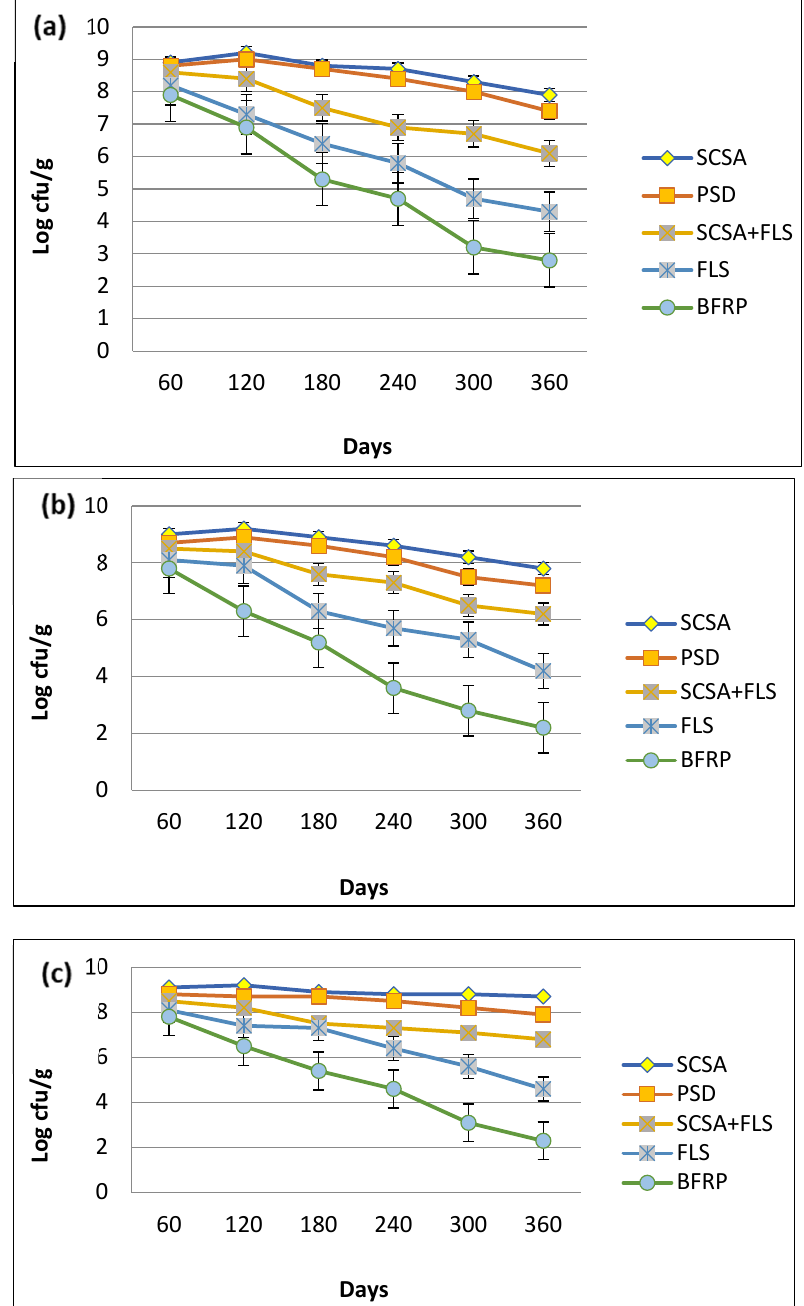
Figure 2. Shelf-life assessment of E. adhaerens MSN12 ( a ), B. cereus MEN8 ( b ), and the consortia of MSN12 + MEN8 ( c ), in different supporting materials. CFU g − 1 values were log-transformed (log CFU g − 1 ) to improve the homogeneity of variances and then statistical comparisons were performed using ANOVA and the Duncan’s multiple range test, with significance at p < 0.05.